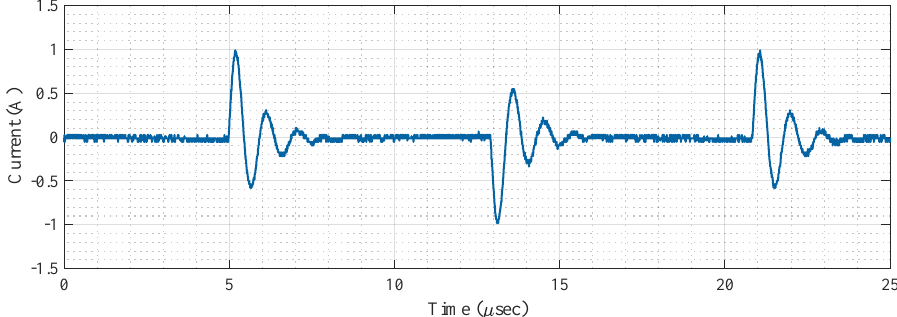
Figure 6. The common mode current due to the parasitic coupling path.